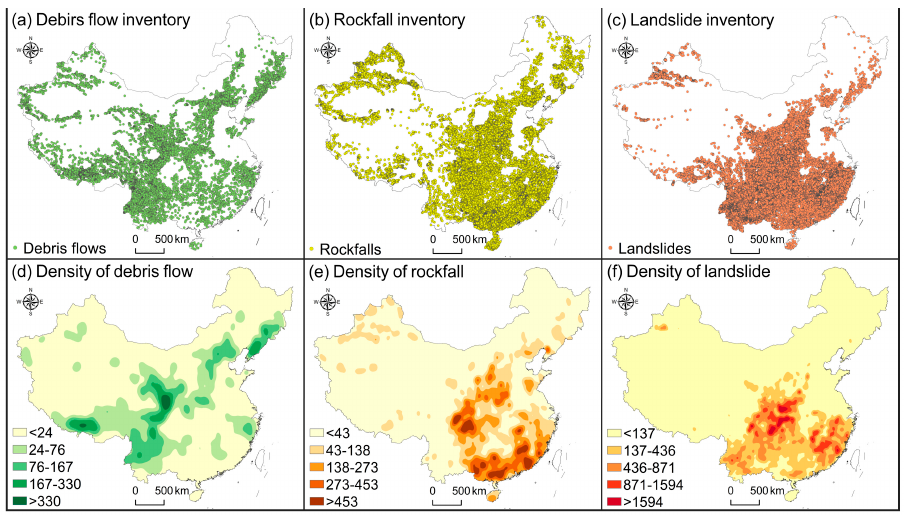
Figure 2. Spatial distribution maps and kernel density maps of three types of mass movements.